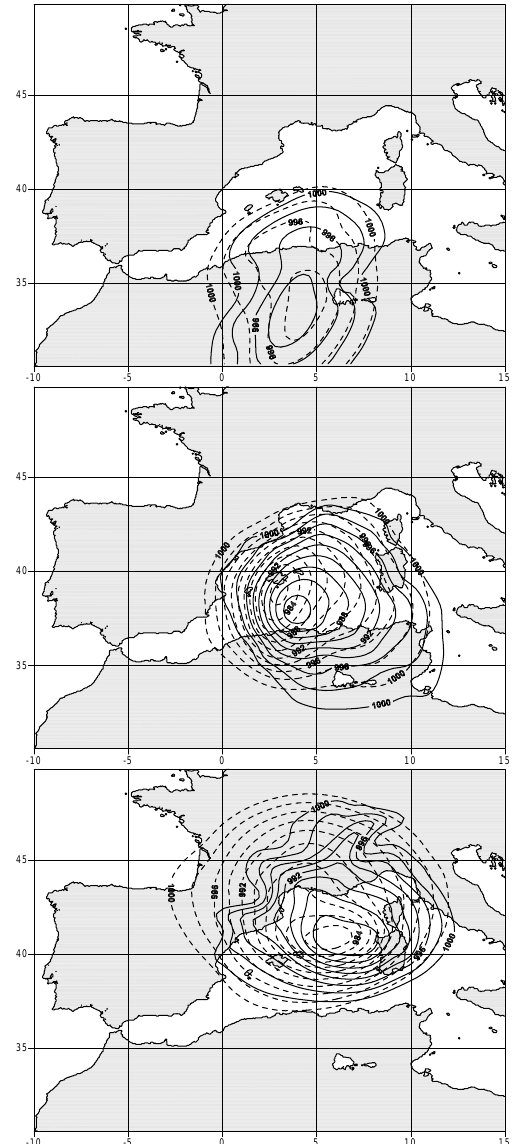
Fig. 17. Surface pressure (hPa) lower than 1000hPa as simulated by C21–23 (solid lines) and NT21–23 (dashed lines) at (a) 06:00UTC, 21December, (b) 18:00UTC, 21December and (c) 06:00UTC,